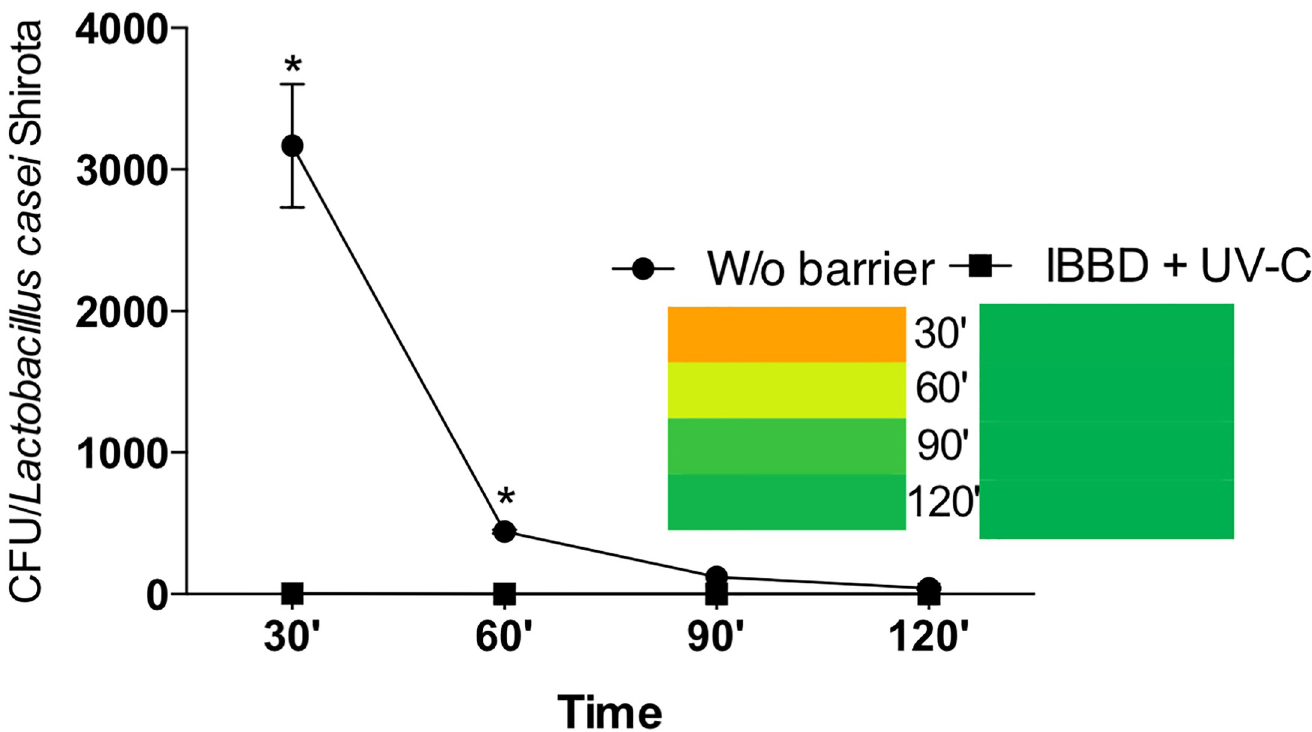
Fig 3. Sedimentation time in the environments of the positive control group (without barrier) and the IBBD + UV-C group after 30, 60, 90 and 120 minutes of activation of the dental drill containing L . casei . � indicate statistical significance (p < 0.0001). Two-way ANOVA and post hoc analysis using Bonferroni’s multiple comparation.